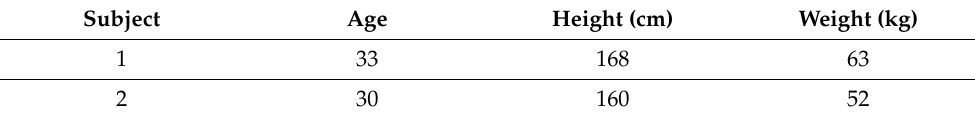
Table 3. Subjects